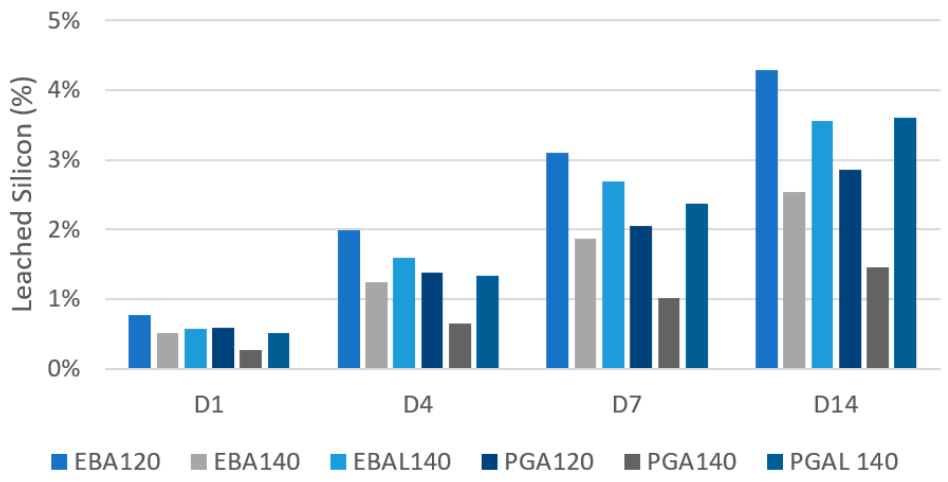
Figure 4. Cumulative leached silicon (%) after 1 day, 4 days, 7 days and 14 days for the different treatment.